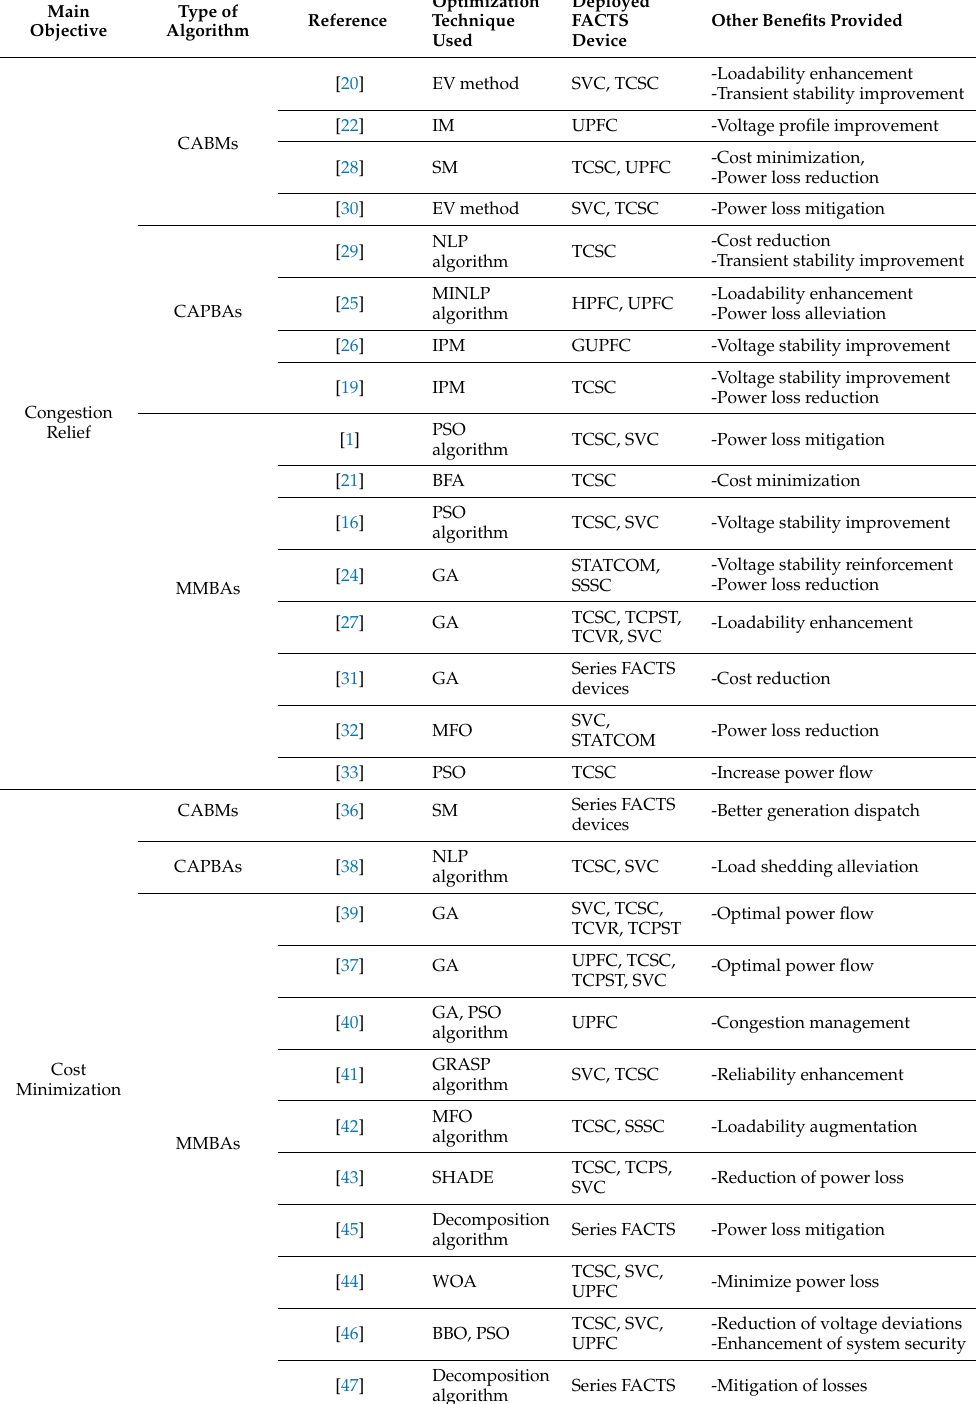
Table 1. Taxonomy of the optimization techniques applied for power system performance